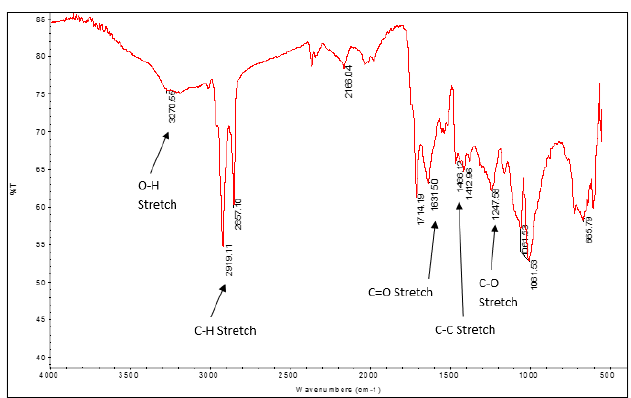
Fig. 2. FTIR spectrum of powdered neem seeds